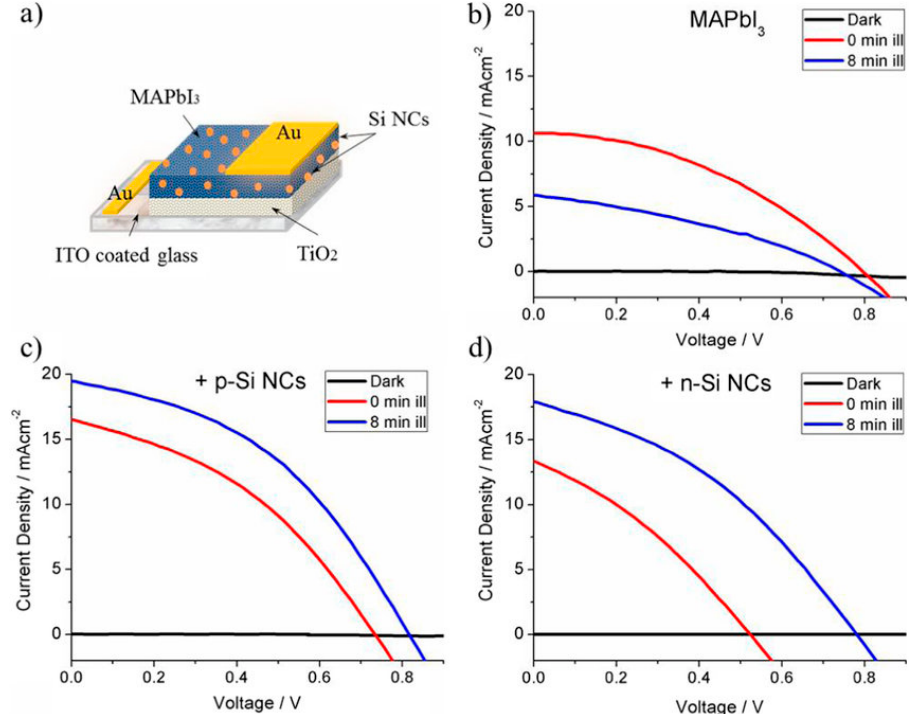
Figure 13. Perovskite-silicon nanocrystal (SiNC) hybrid solar cells show improved device performance especially after light-soaking. ( a ) Schematic of device structure, and current-density voltage (JV) curves for ( b ) MAPbI 3 alone, ( c ) MAPbI 3 with p-type SiNCs, and ( d ) n-type SiNCs. Reported from ref. [85], with permission from Elsevier, 2018.